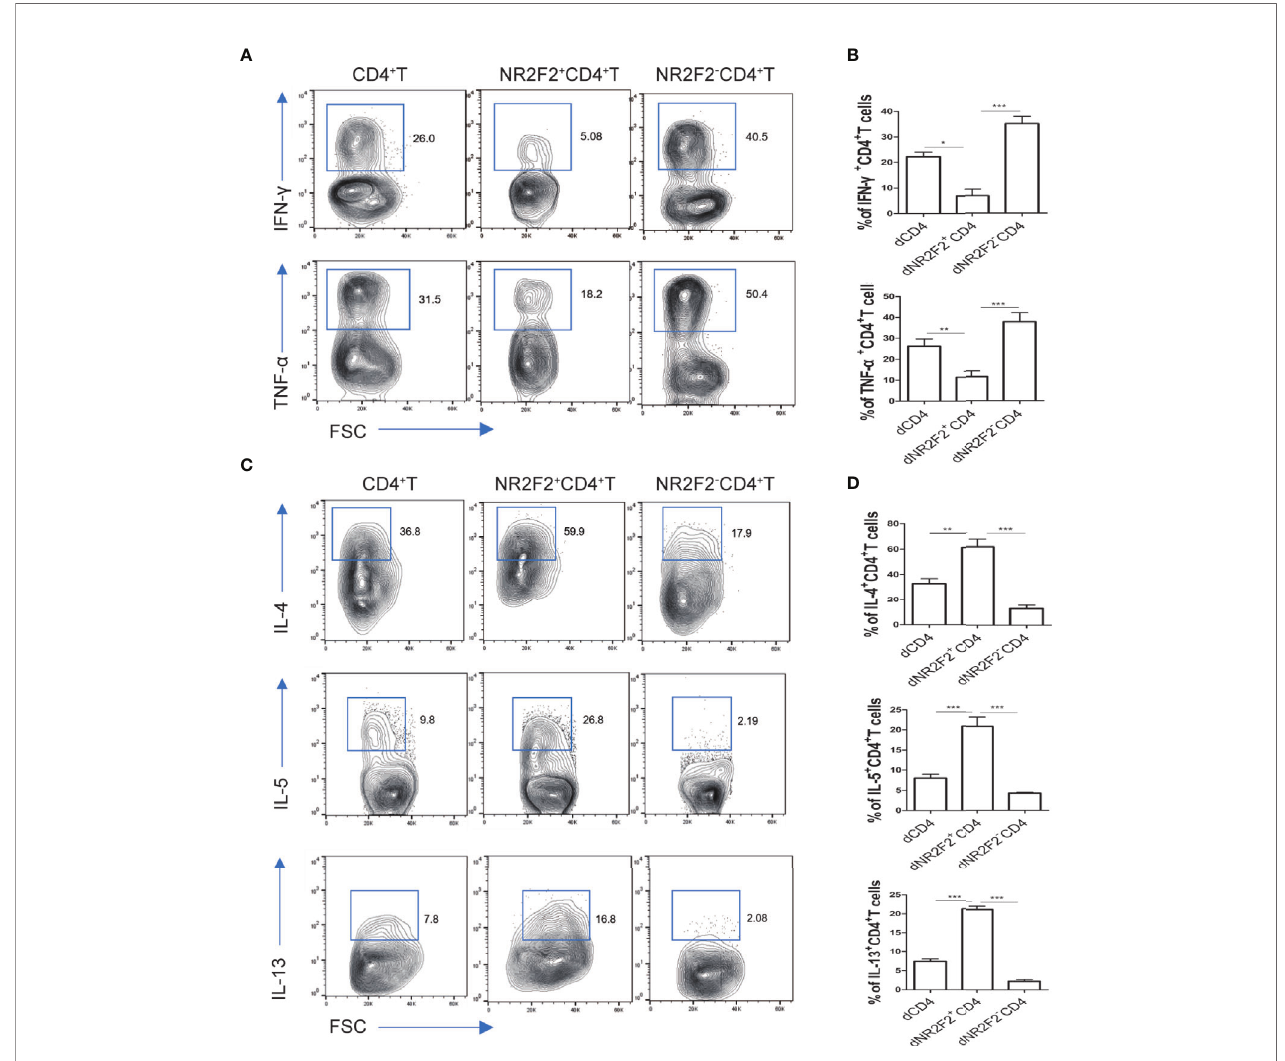
FIGURE 3 | NR2F2 + decidual CD4 + T cells display a Th2 shift. The relative amounts of Th1-type cytokines (A, B) and Th2-type cytokines (C, D) in gated total dCD4 + T cells, NR2F2 - dCD4 + T cells and NR2F2 + dCD4 + T cells, respectively, are shown. Data in the right are presented as the mean ± SEM(n=10). * P < 0.05, ** P < 0.01, and *** P <